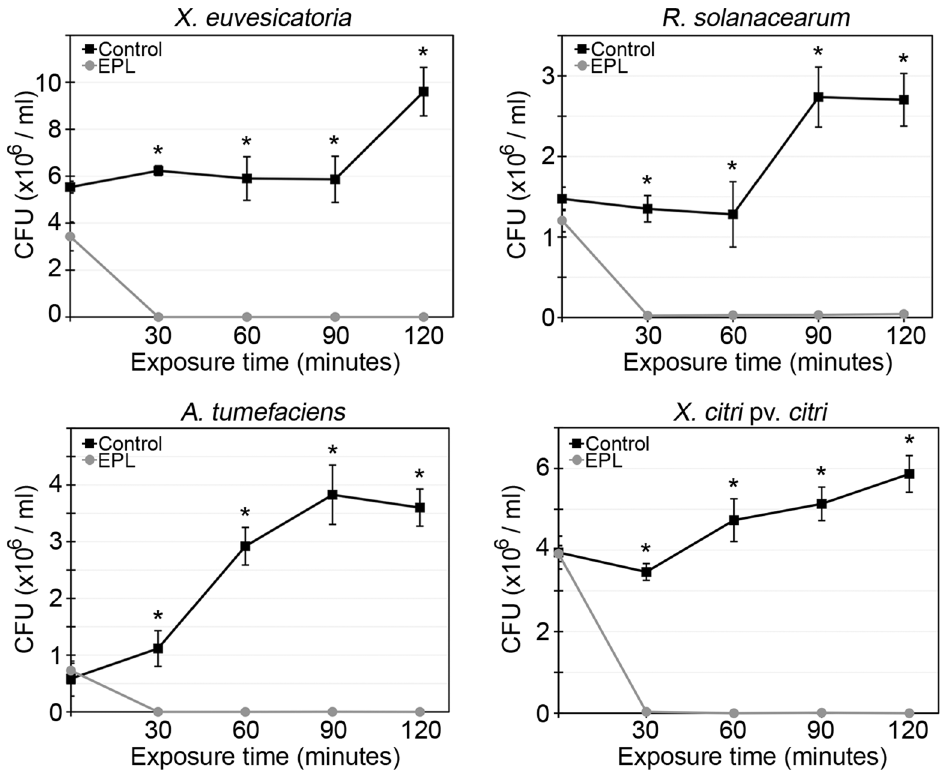
Figure 2. Growth inhibition curves in the presence of EPL treatment at MIC. Aliquots were taken in 30-min intervals, during 2 h, serially diluted and plated. Plates were kept for two days at 28 °C when CFU were counted. The numbers of CFU/ml are the averages for three replicates plating from each sample, and the error bars represent the standard deviations. Percentage of cell mortality was calculated as the ratio of cell counts in the treated group with EPL to those in the control